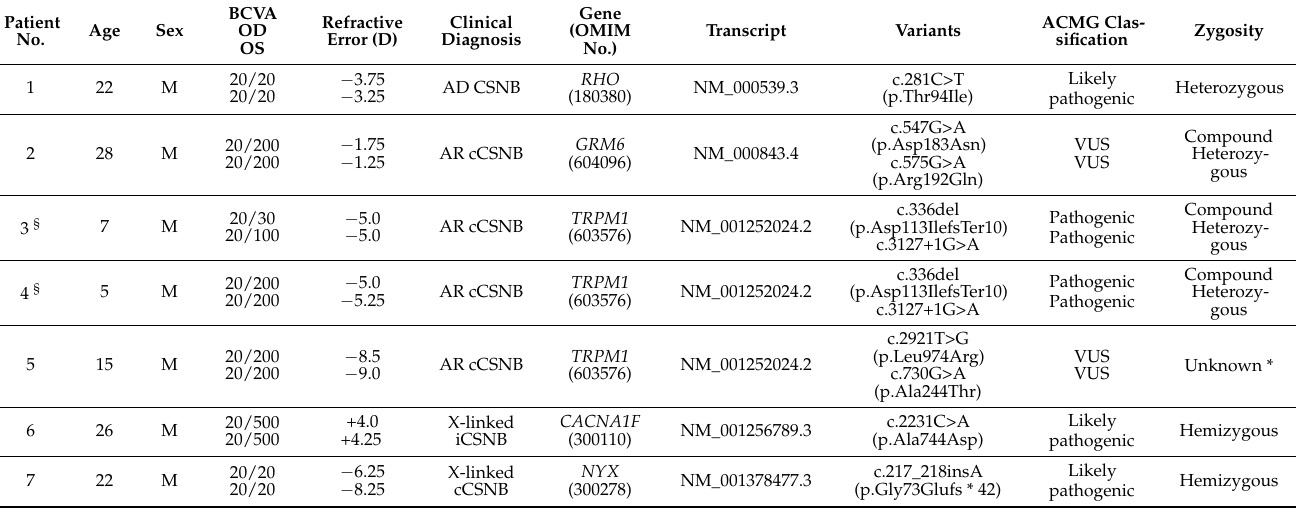
Table 2. Demographic summary of our patients diagnosed with congenital stationary night blindness (CSNB). The mean age at diagnosis was 17.9 years.